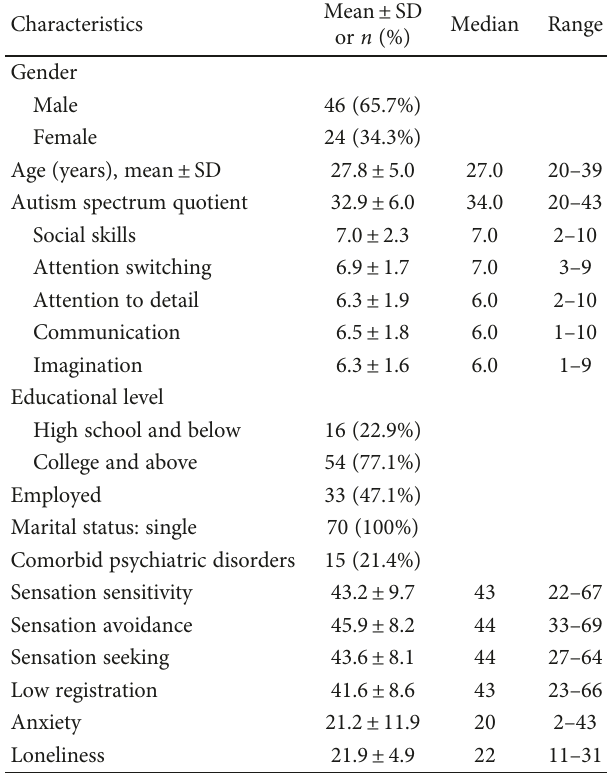
Table 1: Demographic